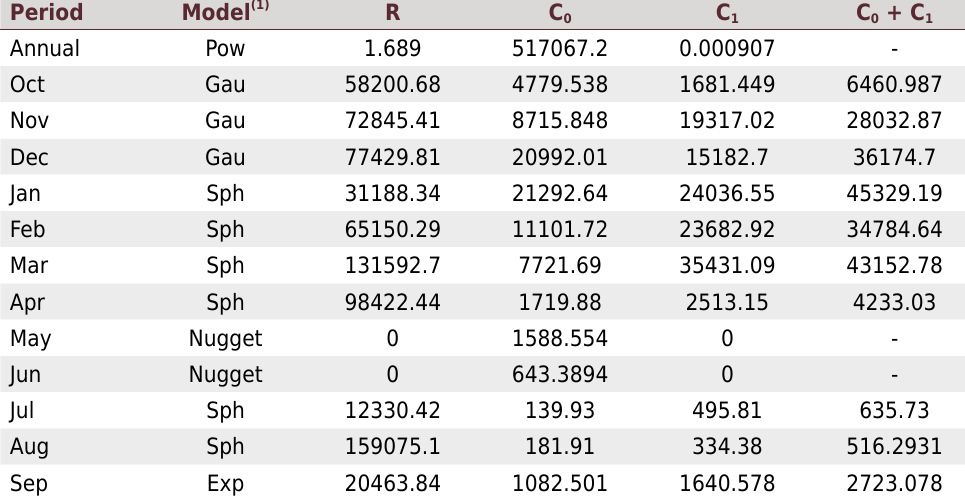
Table 3. Parameters of models fitted to experimental semivariograms of rainfall erosivity